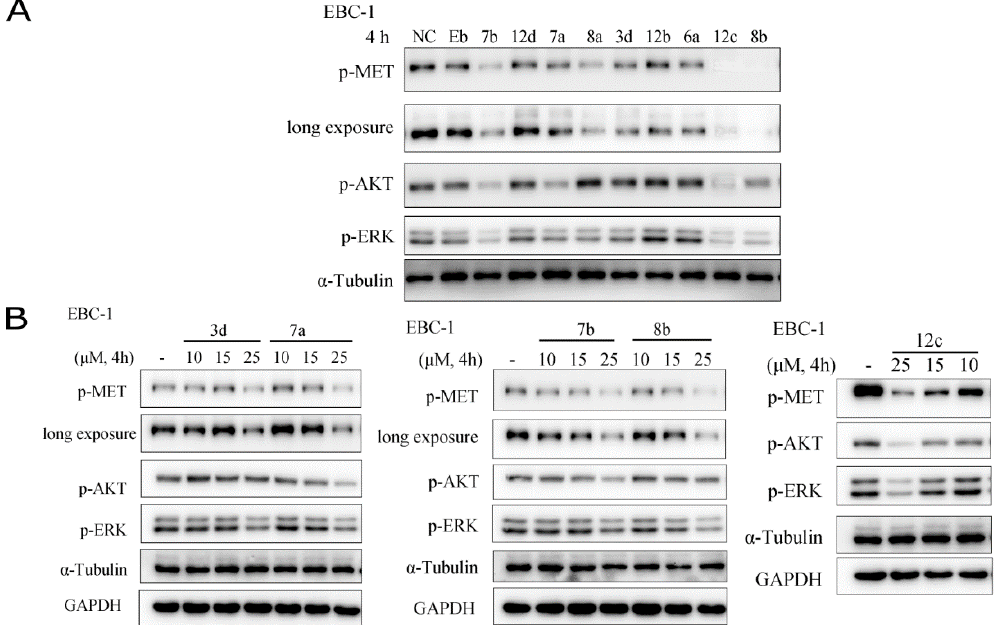
Figure 4. Effects of Ebselen and compounds on p-c-Met, p-AKT and p-ERK in EBC-1 cancer cells. ( A ) Western blot analysis in the EBC-1 cells treated with concentrations near the IC 50 values of compounds for 4 h. Ebselen was unable to inhibit the phosphorylation of c-Met at 25 µ M. ( B ) Representative Western blot analysis in the EBC-1 cells treated with increasing concentrations of compounds 3d , 7a , 7b , 8b and 12c , as indicated. All of the tested compounds could inhibit the phosphorylation of Met, AKT and ERK in a dose-dependent manner. Table 2. IC 50 of compounds ( 3d , 7a , 8a , 8b and 12c ) in four cancer cell lines and EBC-1.